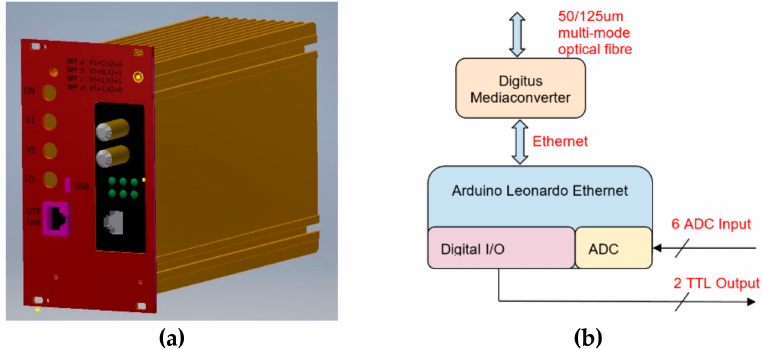
Figure 11. Design of the WS monitor and control module: 3D drawing of the first module showing ( a ) the front-panel and ( b ) system architecture.